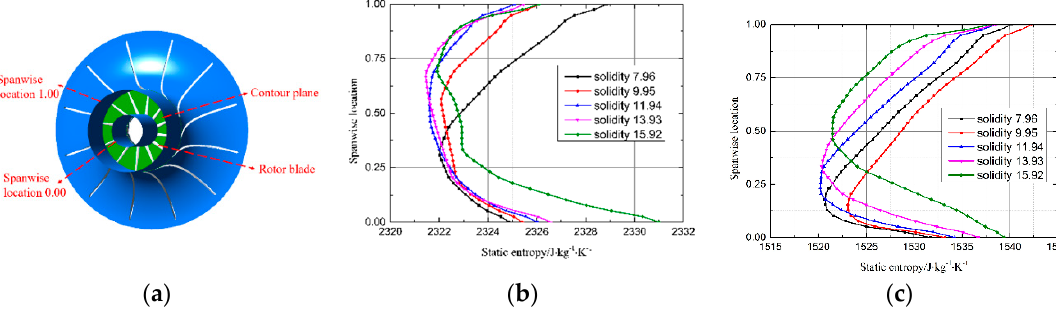
Figure 12. Averaged static entropy along spanwise location at turbine outlet: ( a ) location of graphical results; ( b ) SCO 2 ; ( c ) air.